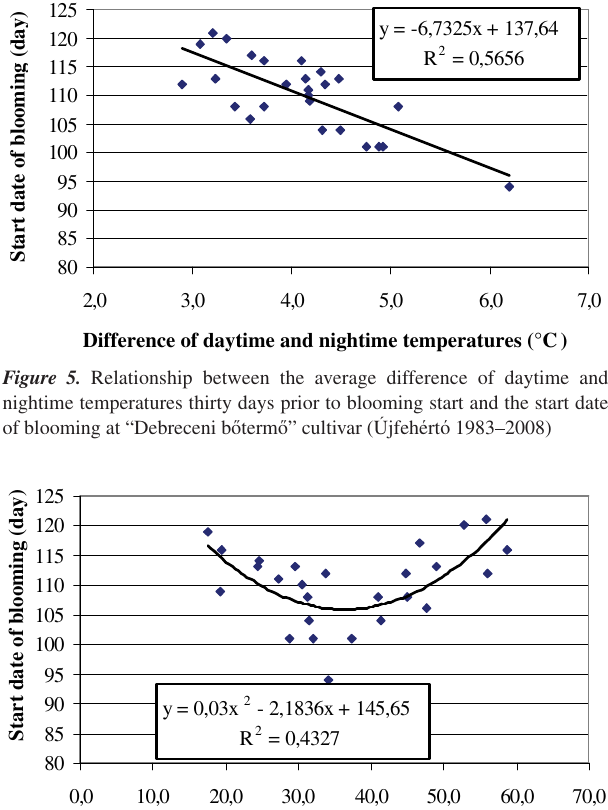
y = -6,7325x + 137,64